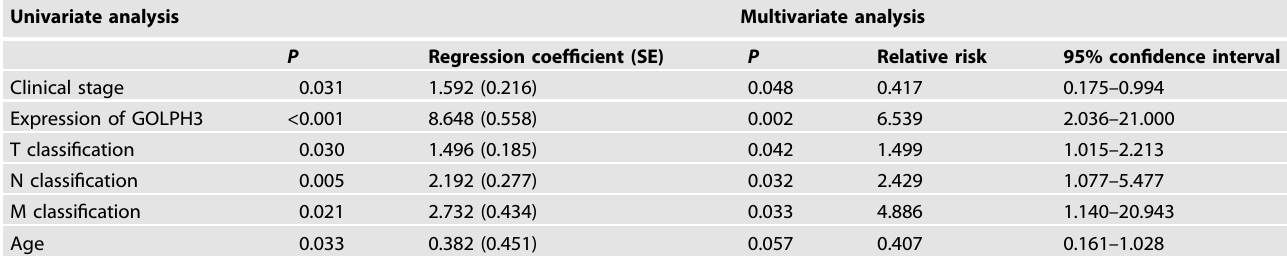
Table 4. Univariate and multivariate analysis of different prognostic parameters in patients with colorectal cancer. Univariate analysis